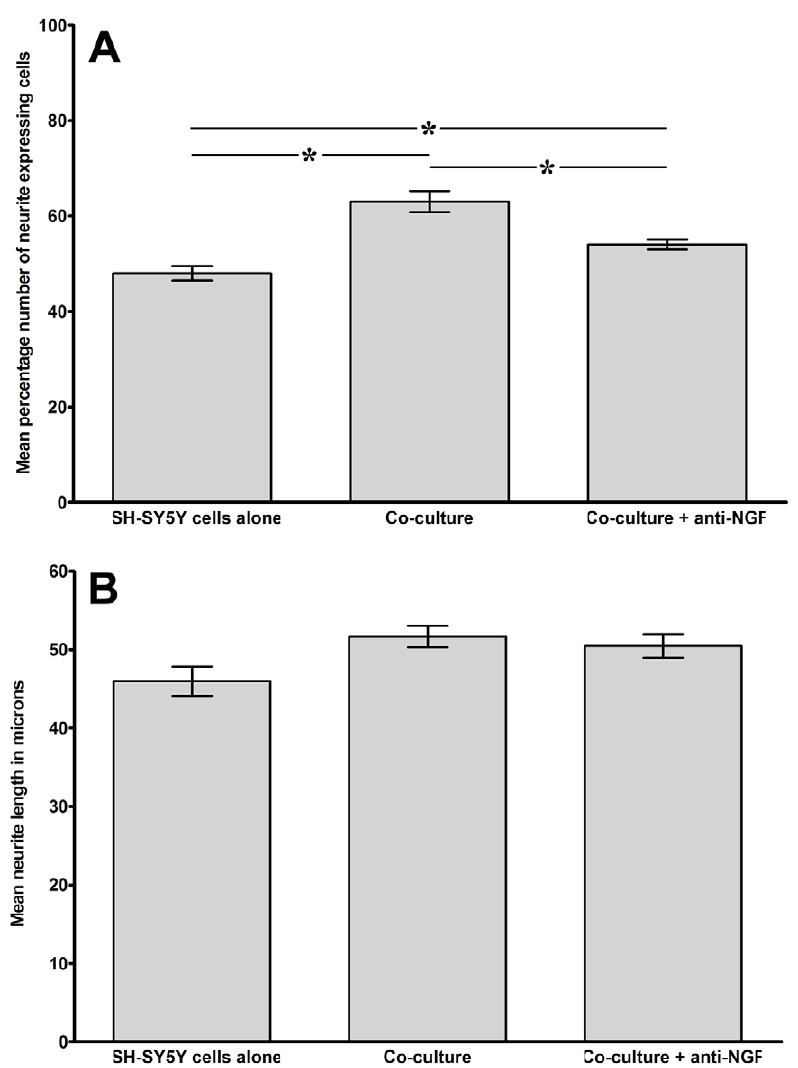
Figure 4. Analysis of neural cell behaviour following co-culture with degenerate human NP cells with or without addition of anti- NGF antibody. Histograms illustrating the percentage number of neurite expressing cells (A) and mean neurite length (B) from differentiated SH- SY5Y cells co-cultured with degenerate NP cells without contact for 48 hours with or without addition of anti-NGF antibody (n=3; * =P , 0.05).